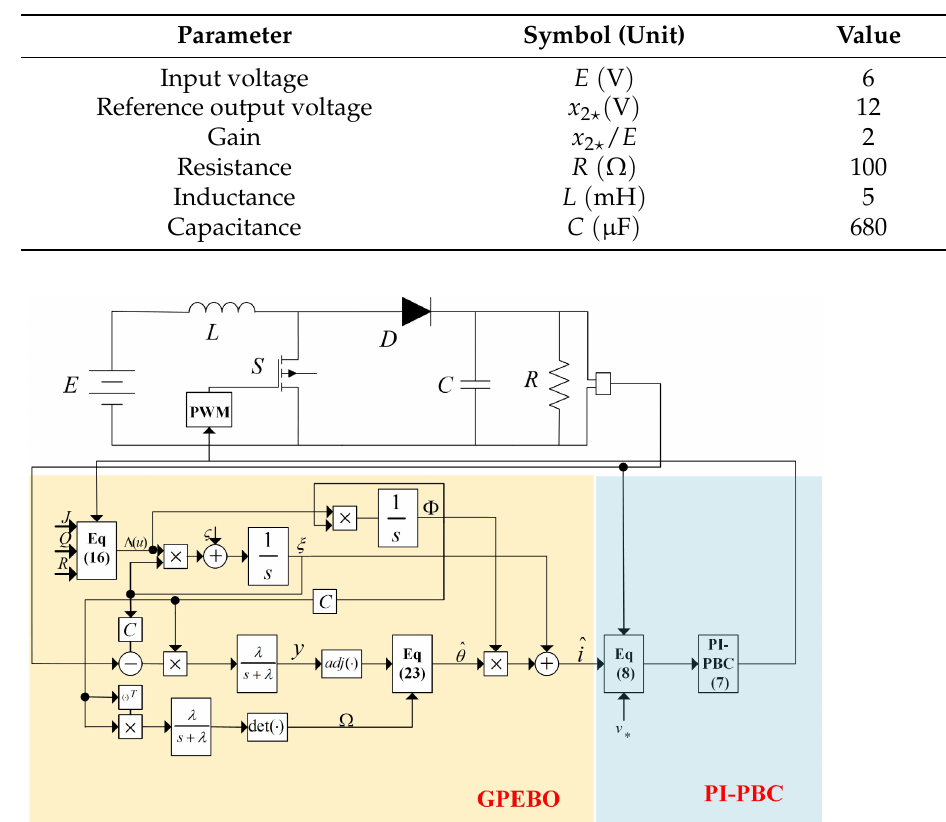
Table 1. Simulation/experimental set—points and physical parameters.